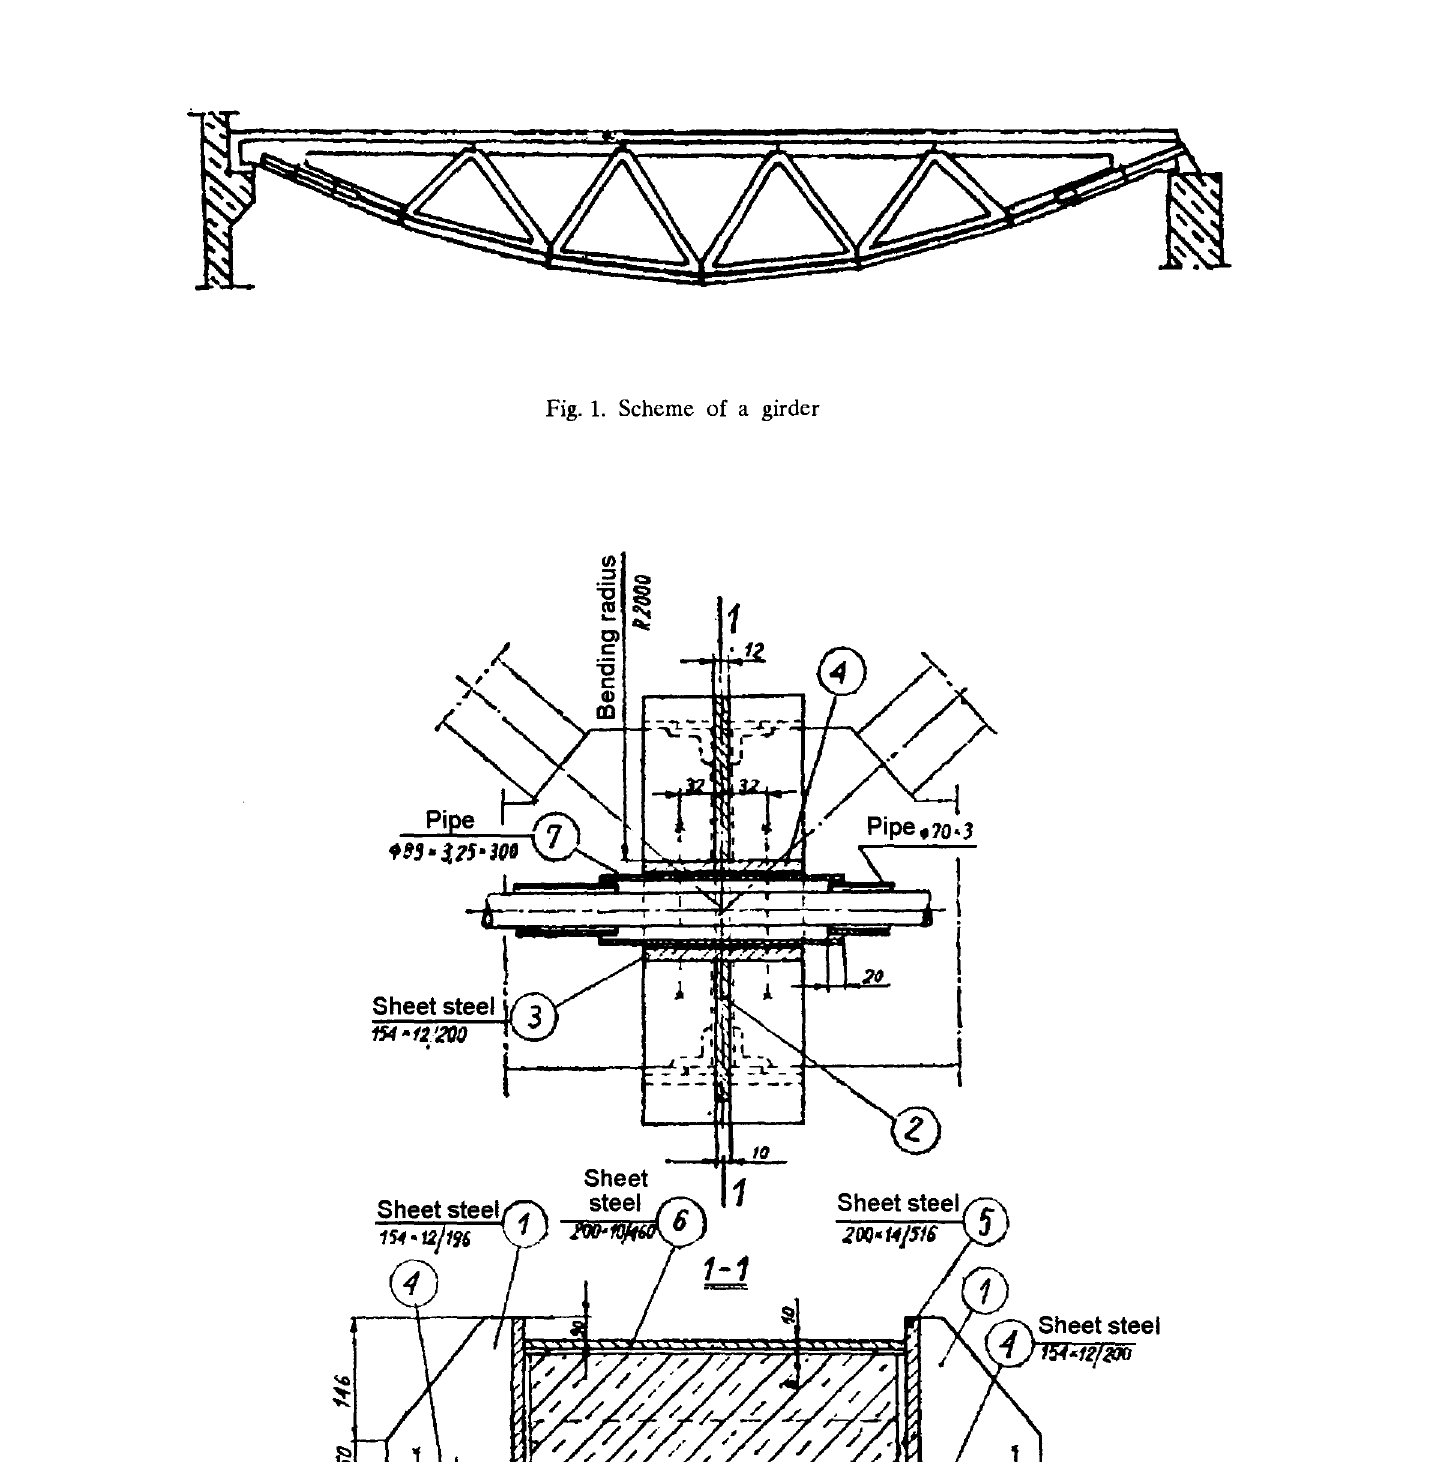
Fig. 1. Scheme of a girder